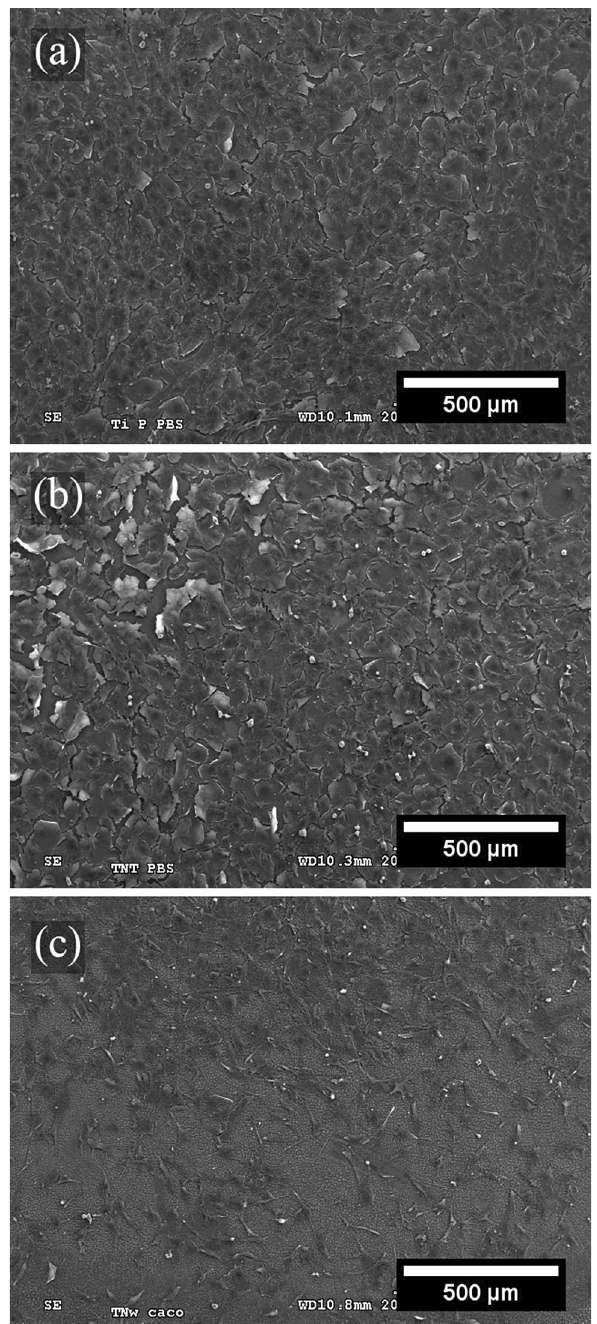
Figure 7. Scanning electron micrographs of MC3T3-E1 cells after 48 h of culture on the surfaces of the ( a ) flat TNZT, ( b ) TNT, and ( c ) TNW